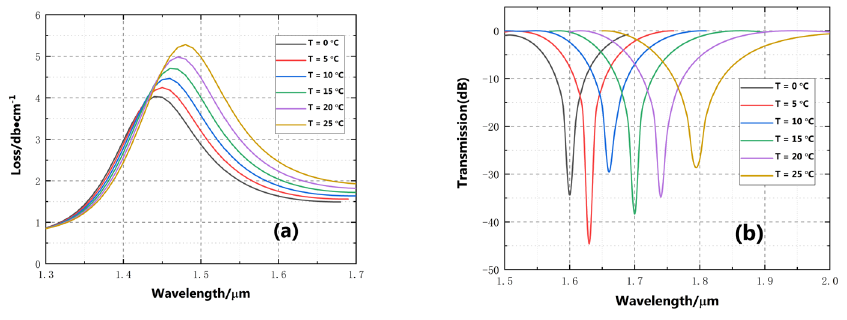
Figure 7. The loss spectra ( a ) and transmission spectra ( b ) under different temperatures for the optimized sensor, H = 0 mT.